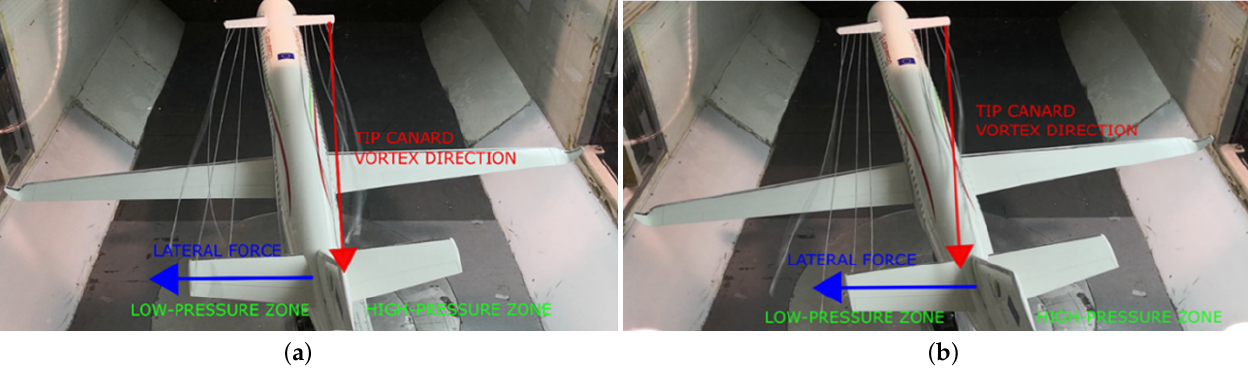
Figure 24. Simple canard wake visualisation through wool yarns stitched to the canard trailing edge: ( a ) β = 8 deg; ( b ) β = 10 deg.